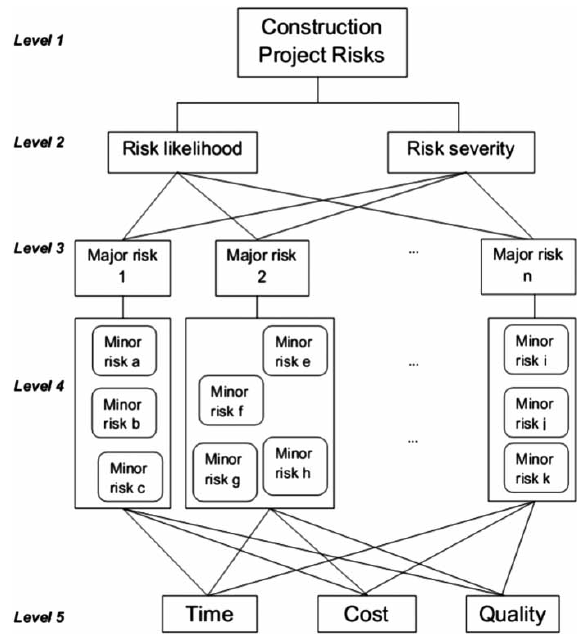
Fig. 2. Risk likelihood and risk